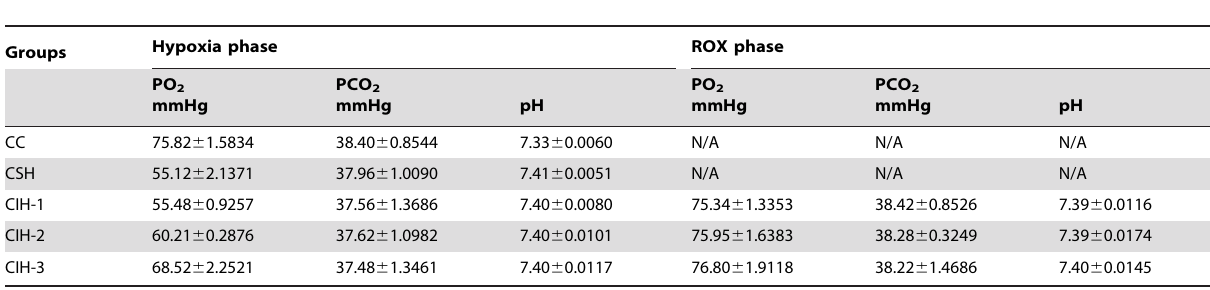
Table 3. The exposure environment at the cellular level provided by cell IH